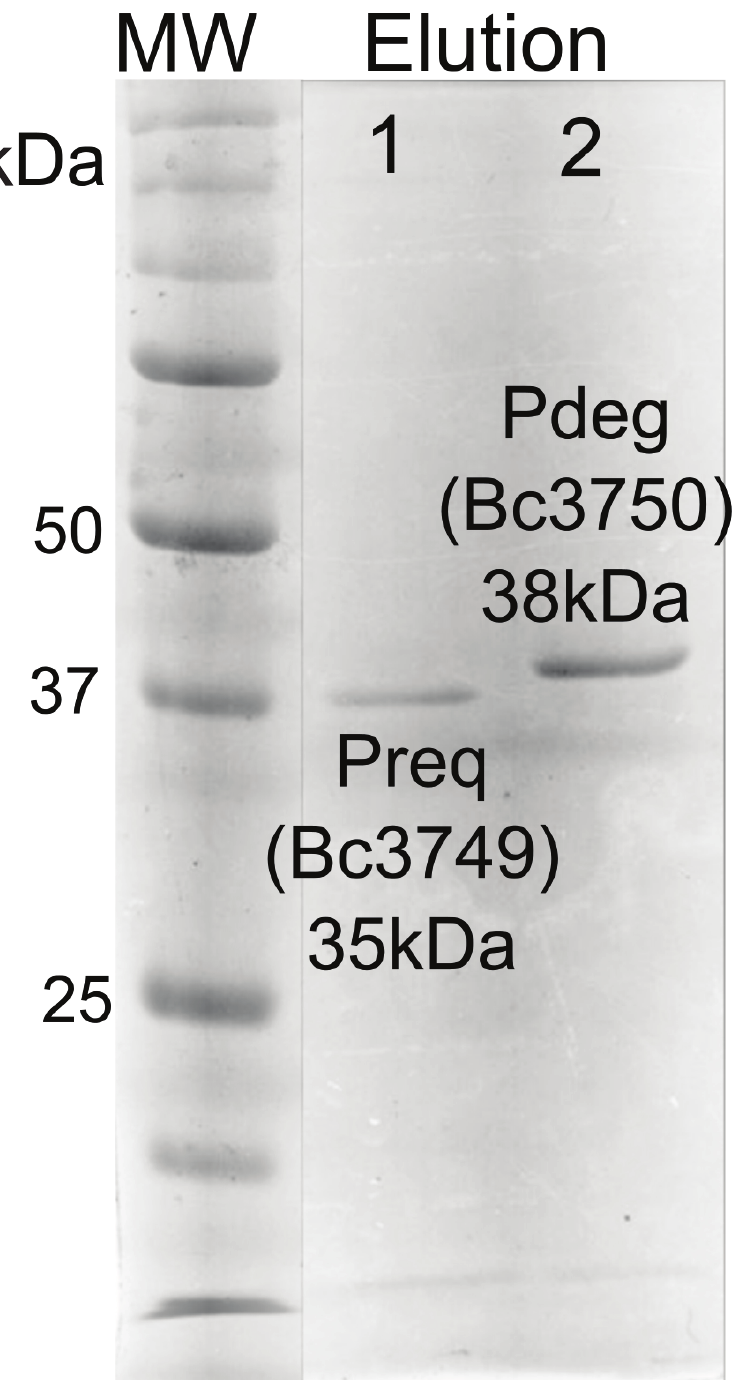
Fig 2. SDS — PAGE analysis of the B. cereus ATCC 14579 purified recombinant Bc3750 (Pdeg) and Bc3749 (Preq) proteins involved in the biosynthesis of UDP-QuiNAc. Protein standards are shown on the right in kDa. The final elution fraction (E7) of purified recombinant proteins from affinity column is shown for Bc3749 (lane 1) and Bc3750 (lane 2).